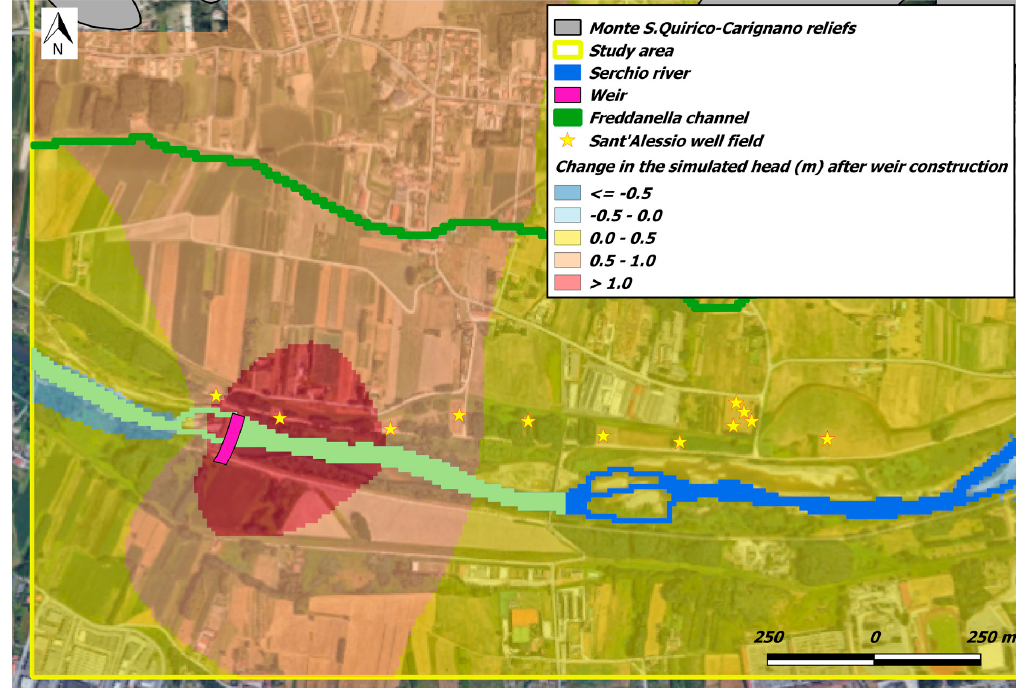
Figure 10. Simulated di ff erence in groundwater head between pre- and post-operam of the Sant’Alessio